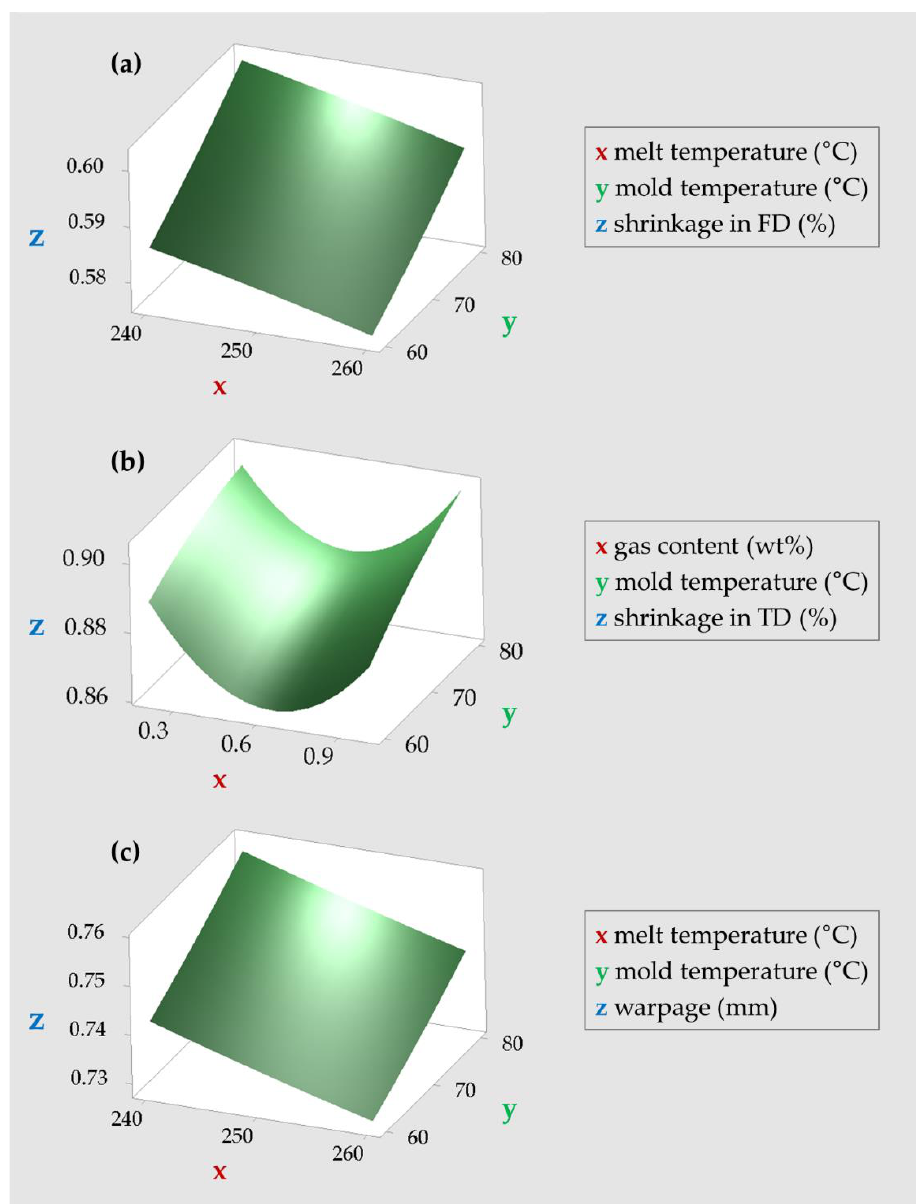
Figure 7. Surface plots of ( a ) shrinkage in the flow direction, ( b ) shrinkage in the transverse direction, and ( c ) warpage. Table 9. Optimum condition by response surface